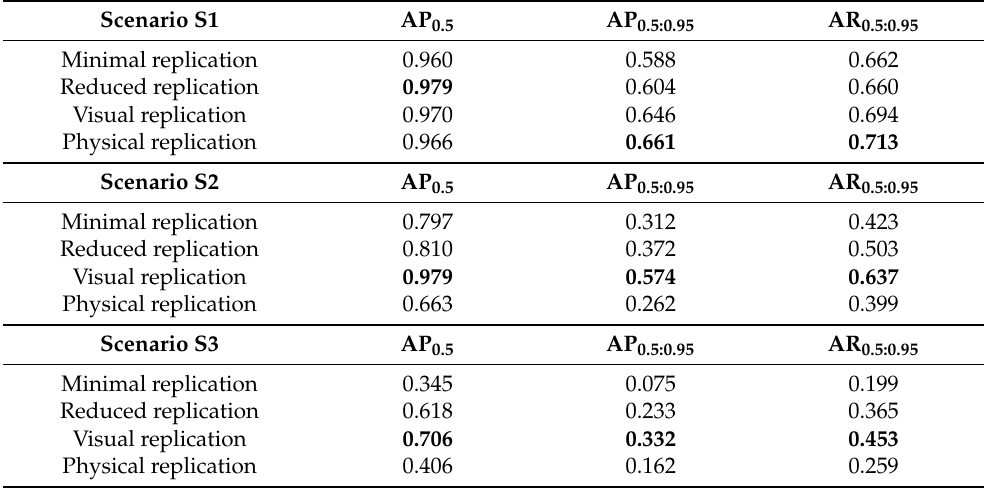
Table 4. Results of the inferences for all replication types and scenarios for control cabinet cables. The best result of each scenario and metric is shown in